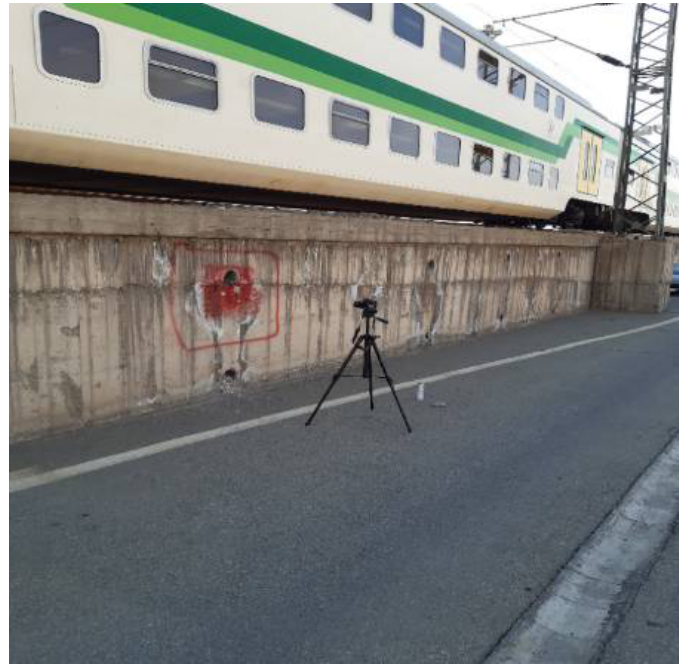
Figure 1. Data gathering process.